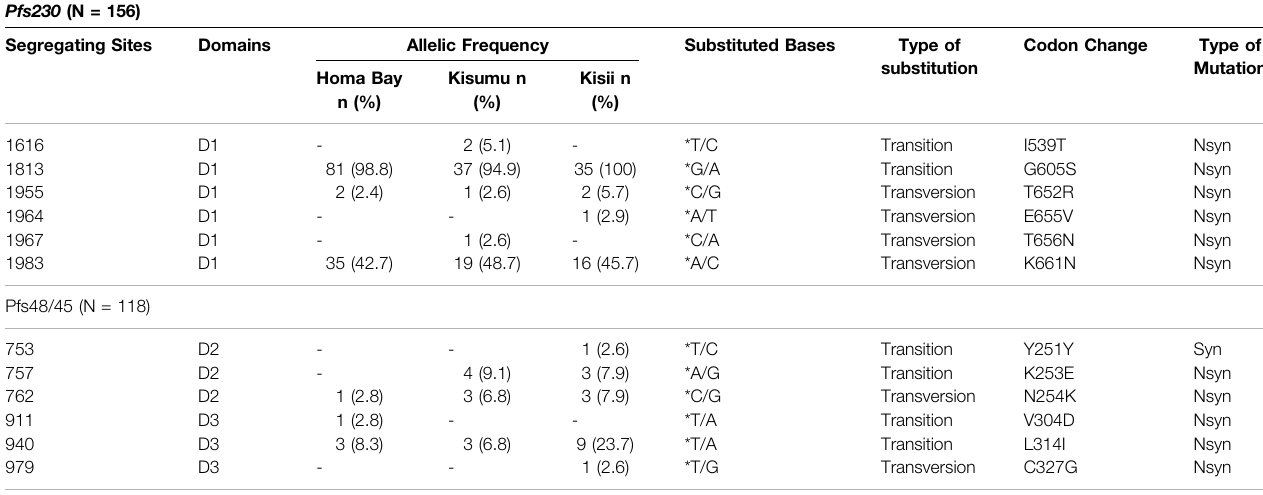
TABLE1| Polymorphicsiteson Pfs230 domainoneand Pfs48/45 domaintwoandthreefromHomaBay,KisumuandKisiiregioninwesternKenyan:numberofsequences harbouring mutations; *: reference (3D7and NF54) allele only; D: Domain; Nsyn: Non-synonymous mutation; Syn: Synonymous mutation; A: Adenine; C: Cytosine; T: Thymine; G: